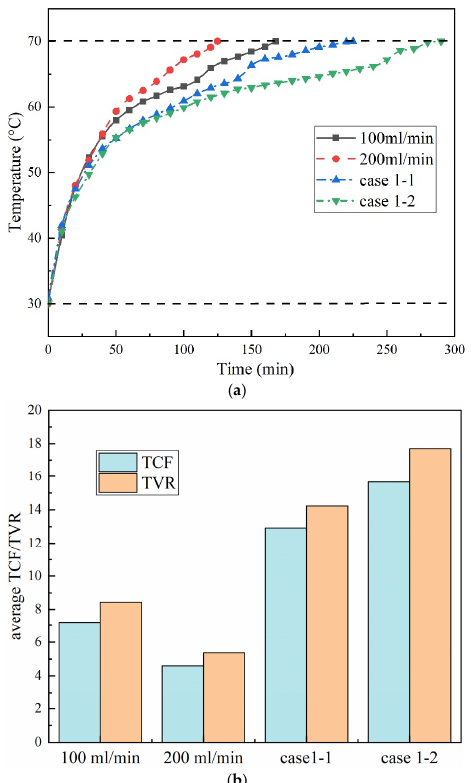
Figure 12. Comparison of thermal − protection performances with different supply methods for working medium. ( a ) Inner − wall temperature. ( b ) Temperature − control coefficient.